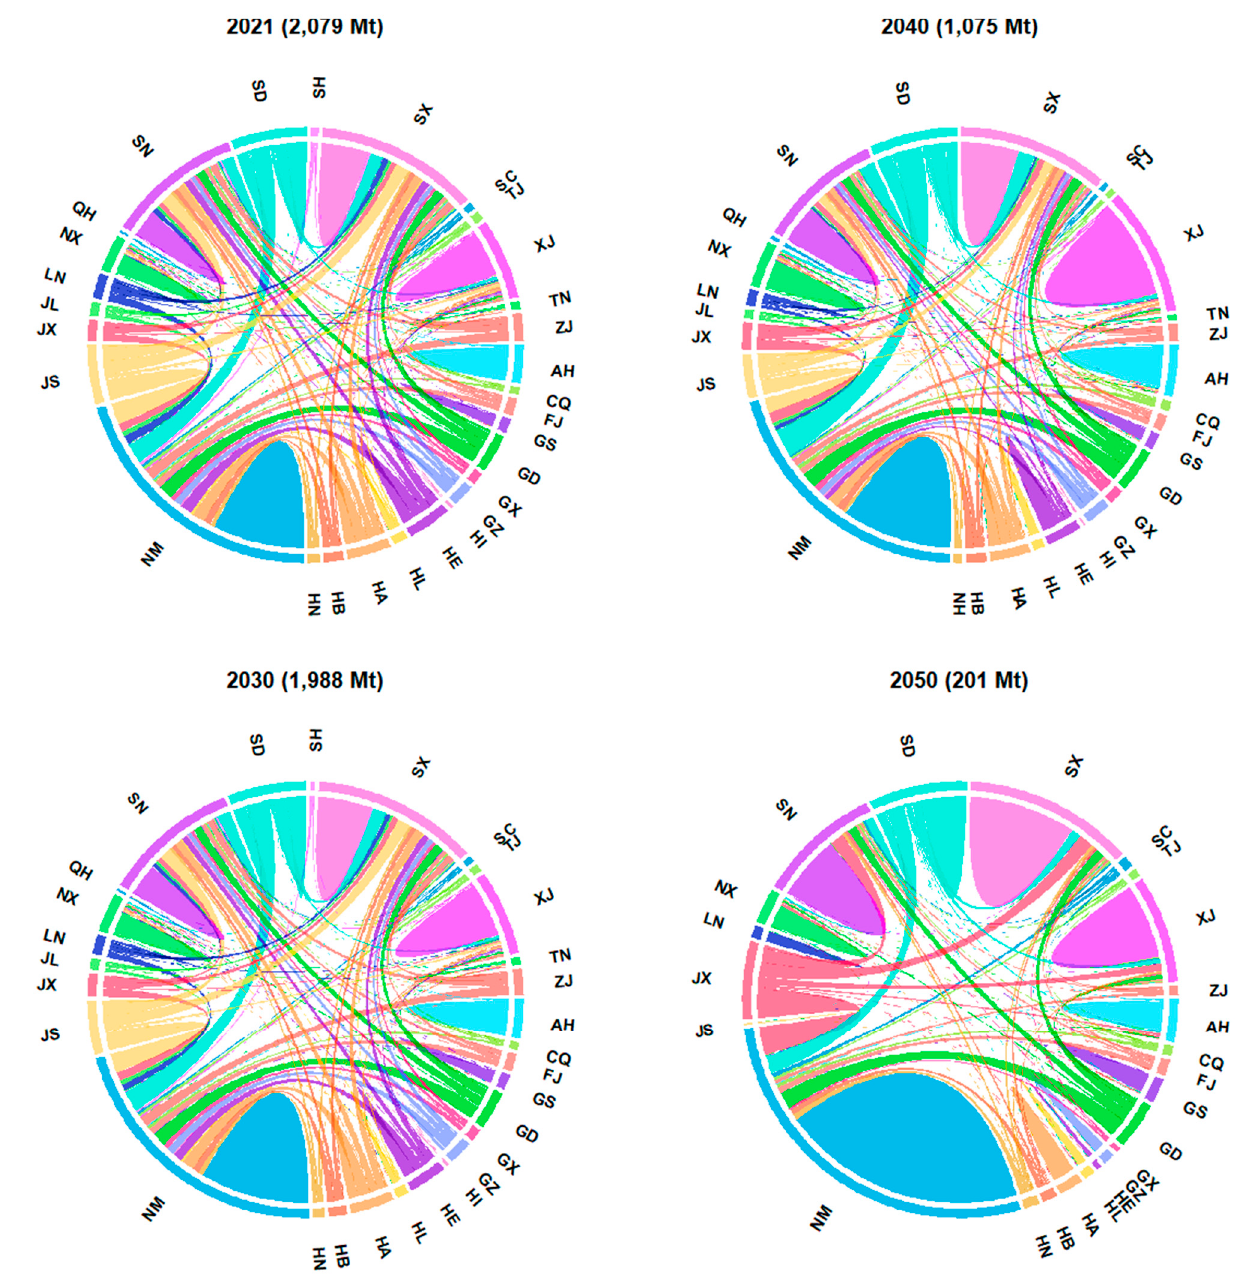
Figure 2. Coal production-consumption network by province, 2021–2050 (B scenario). For province codes, see Appendix A. For a given producer (outer ring), ‘humps’ in the same colour as the outer ring represent coal consumed in the same province in which it is produced. ‘Links’, in different colours, represent coal exported to other provinces, where the colour of the link is that of the destination province.